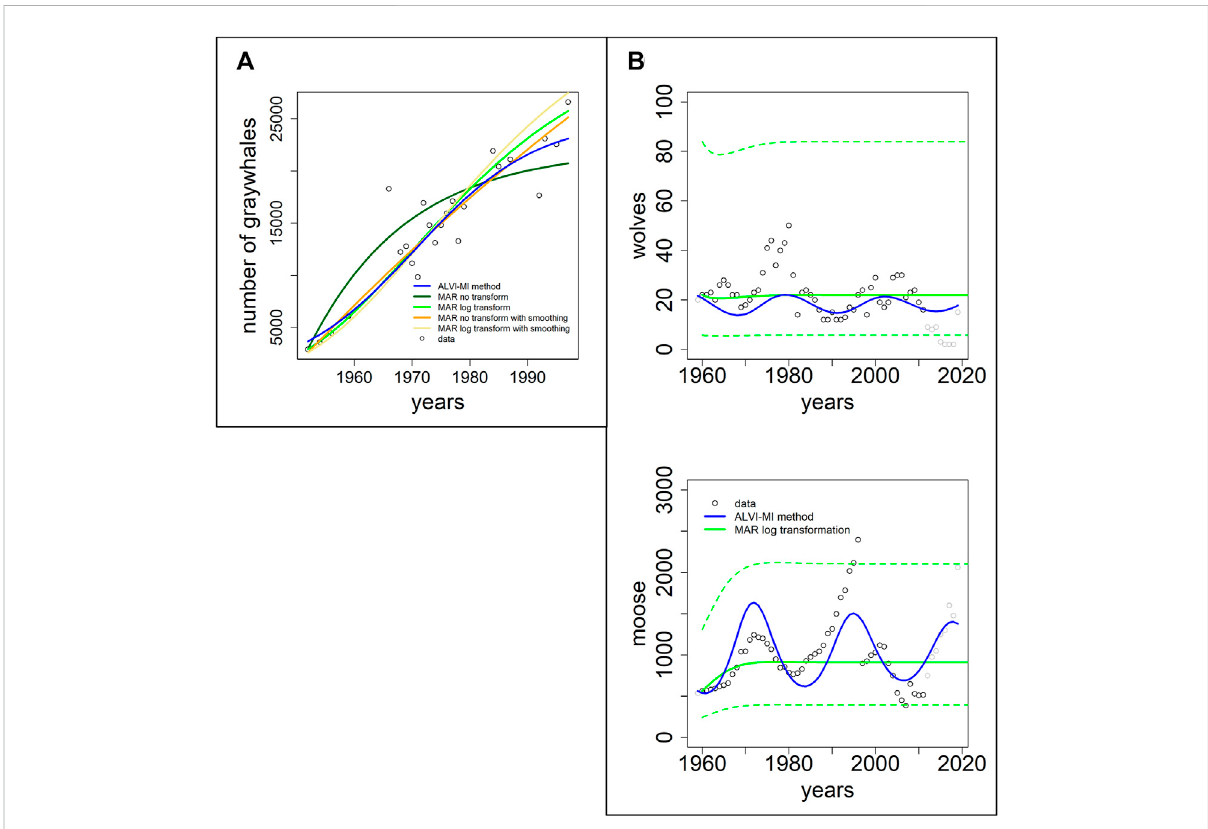
FIGURE 5 Two datasets of wildlife observations. Column (A) Abundance data of gray whales (Gerber et al., 1999). The plot shows results from ALVI-MI in blue;variousMARestimatesaredisplayedwithdarkandlightgreen,orangeandyellowlines.Column (B) WolvesandmooseonIsleRoyale(Vucetich, 2021). The original data used for parameter estimation are displayed with black circles, data not used by the estimation processes are shown in gray, ALVI-MI results are in blue, MAR estimates using log-abundances are displayed with green lines. The dashed lines indicate con fi dence intervals for the MAR estimates. Values of the estimates can be seen in Supplementary Table